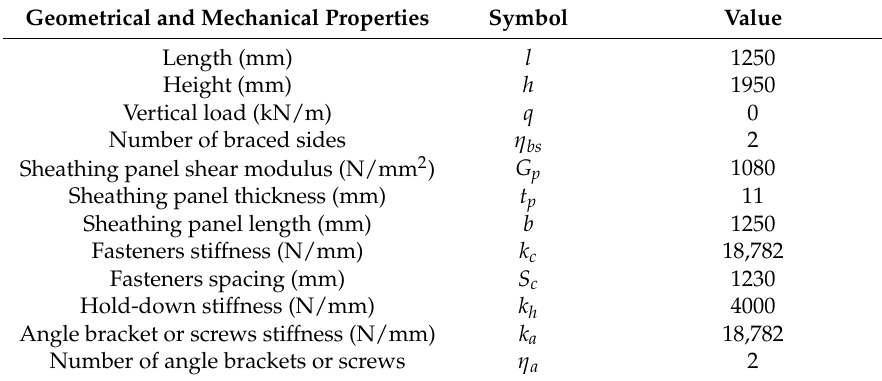
Table 4. Properties of specimen DH.